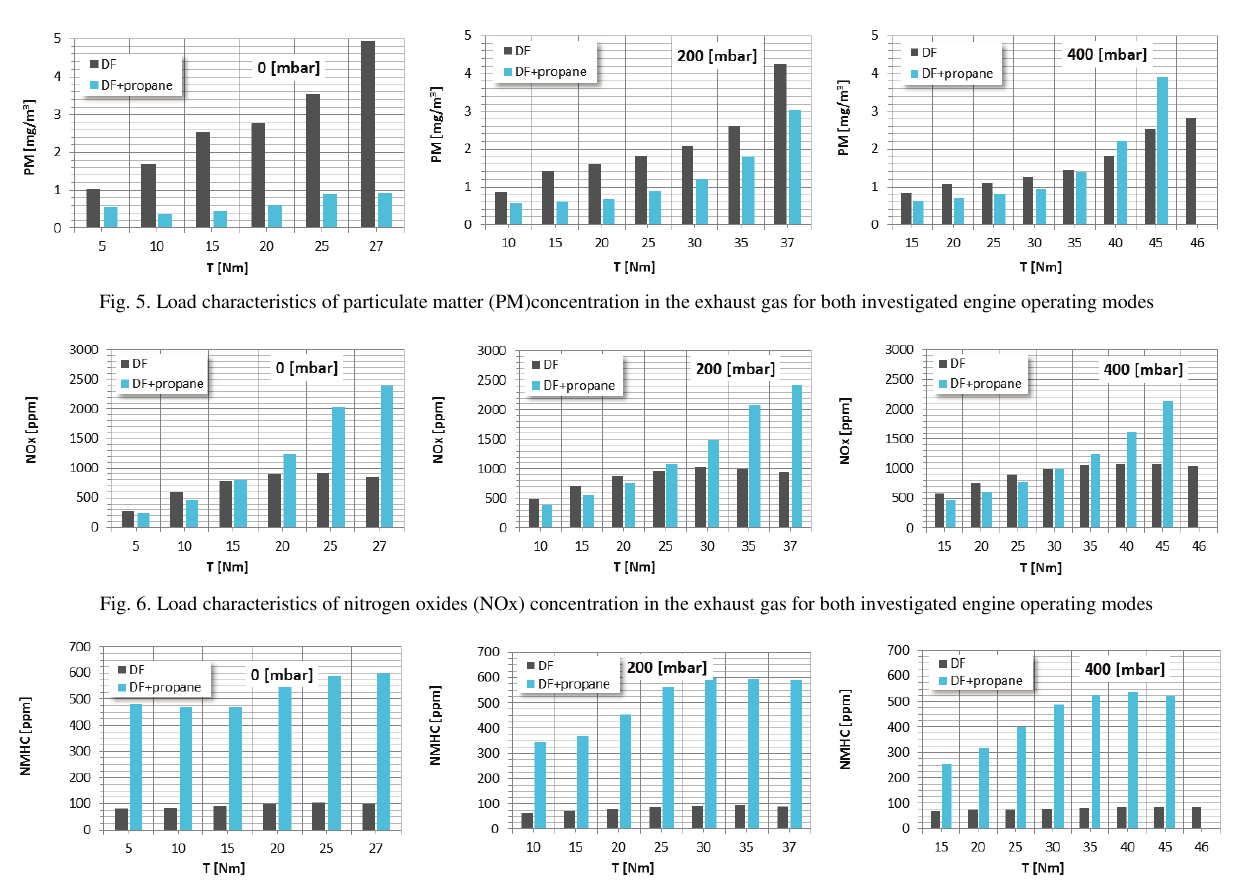
Fig. 4. Load characteristics of unburned propane (C3H8) concentration in the exhaust gas for both investigated engine operating modes